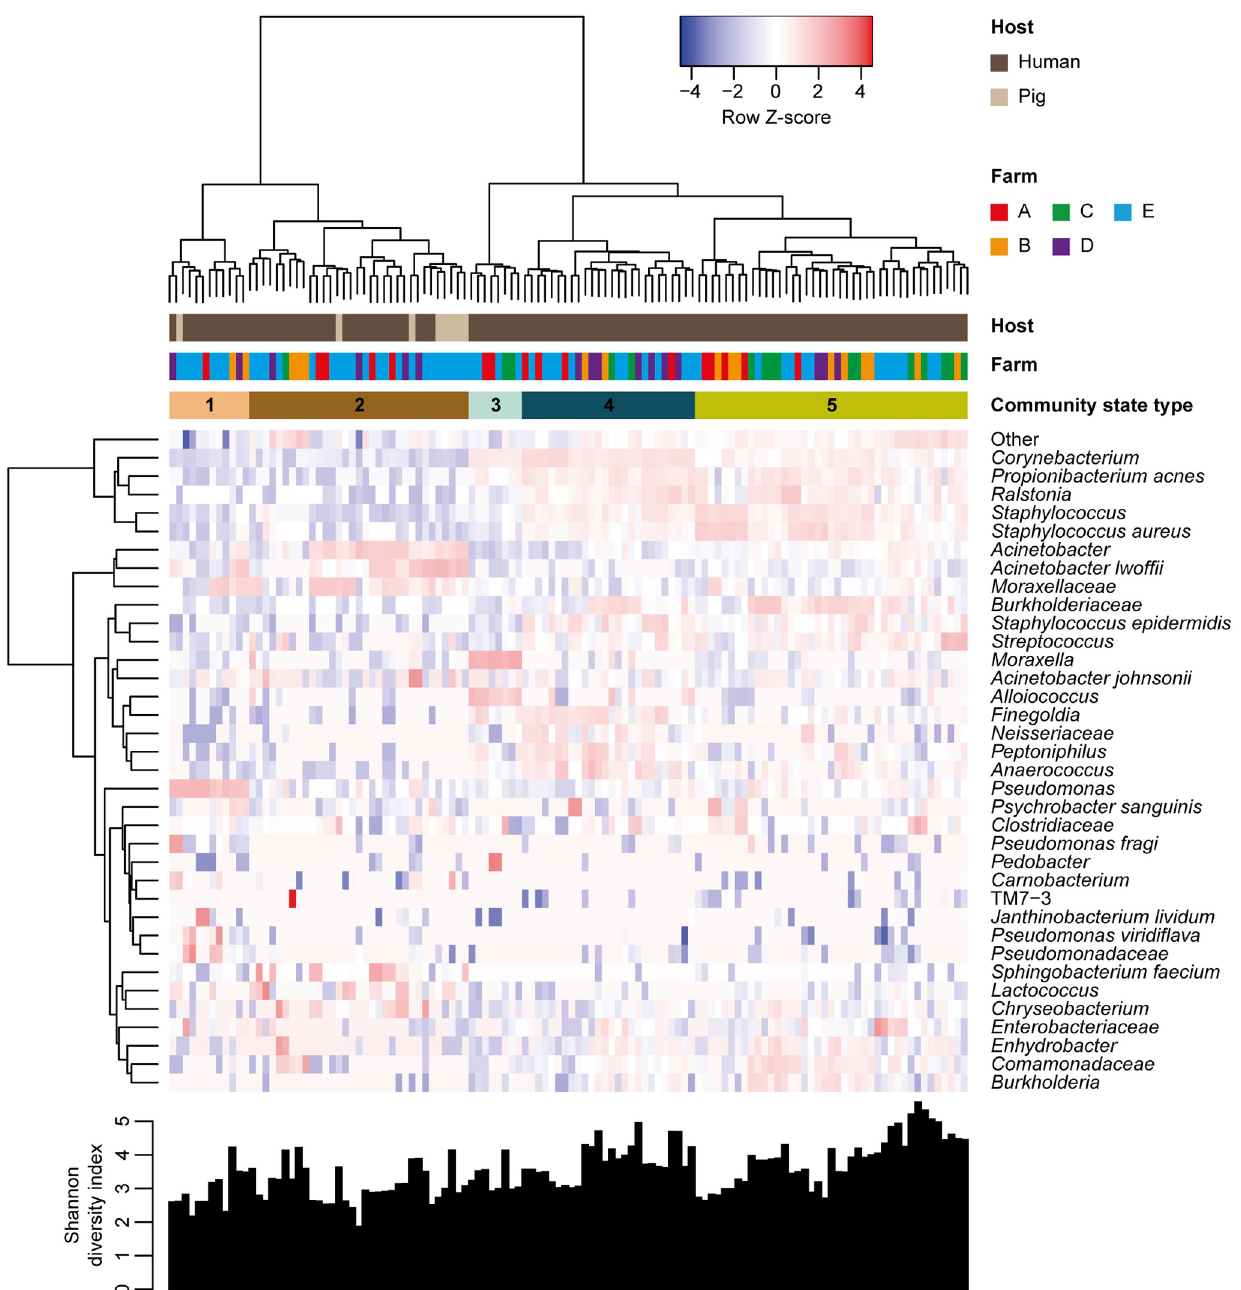
Fig 1. Bacterial community composition in pigs, short-term visitors, and pig farm workers. The heatmap shows log e -transformed proportions of operational taxon units (OTUs) found in samples from pigs, short-term visitors, and pig farm workers. Hierarchical clustering of both samples and OTUs and Shannon diversity indices calculated for each sample are shown. Row Z-score = (value—row mean)/row standard deviation.